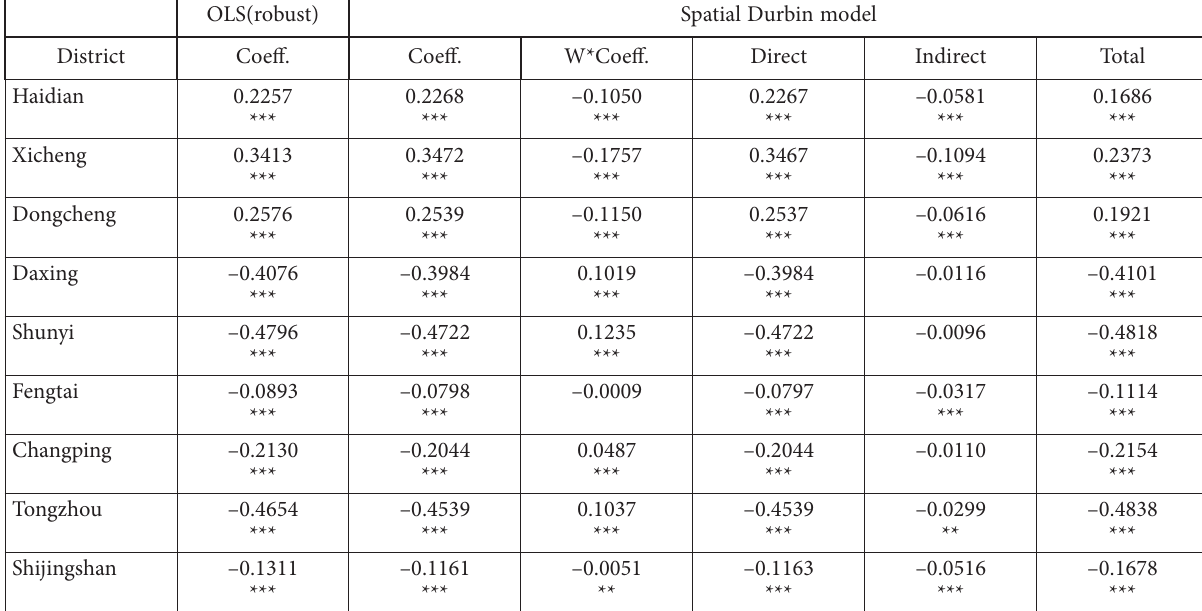
Table A1. Results of location dummy variables for overall study area. The base variable is Chaoyang district OLS(robust) Spatial Durbin model District Coeff.